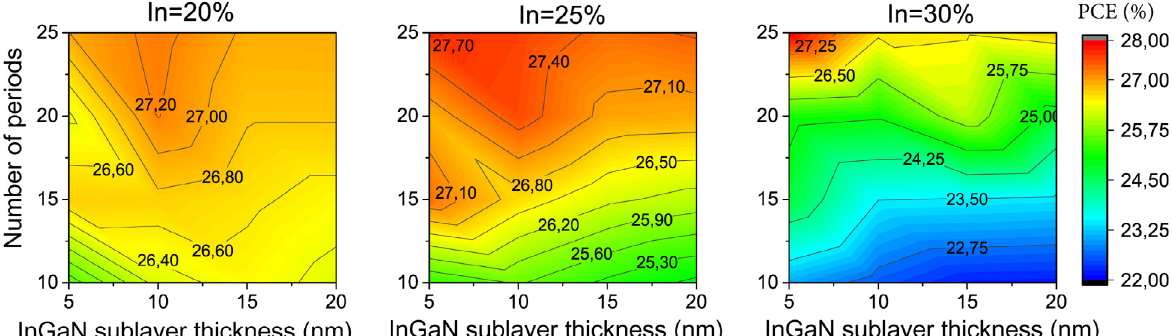
Fig. 7. PCE of InGaN/Si 4-terminal tandem cell as a function of InGaN sublayers’ thickness and number of periods. The indium composition has been varied for 20%, 25% and 30%. We have taken into account the DM at the back side of top